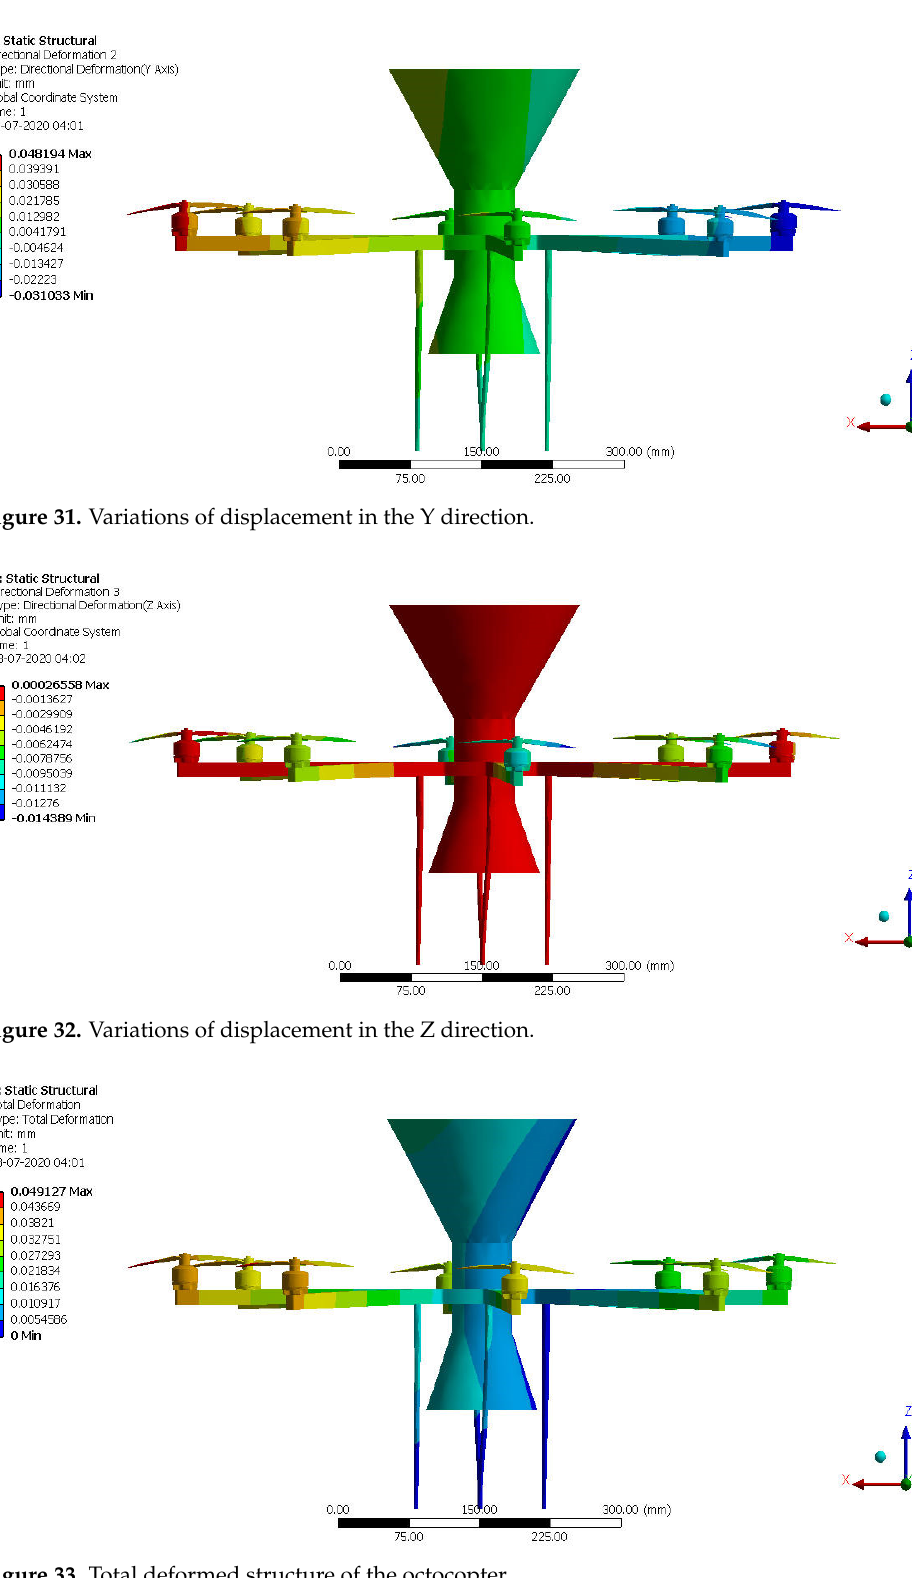
Figure 33. Total deformed structure of the octocopter.